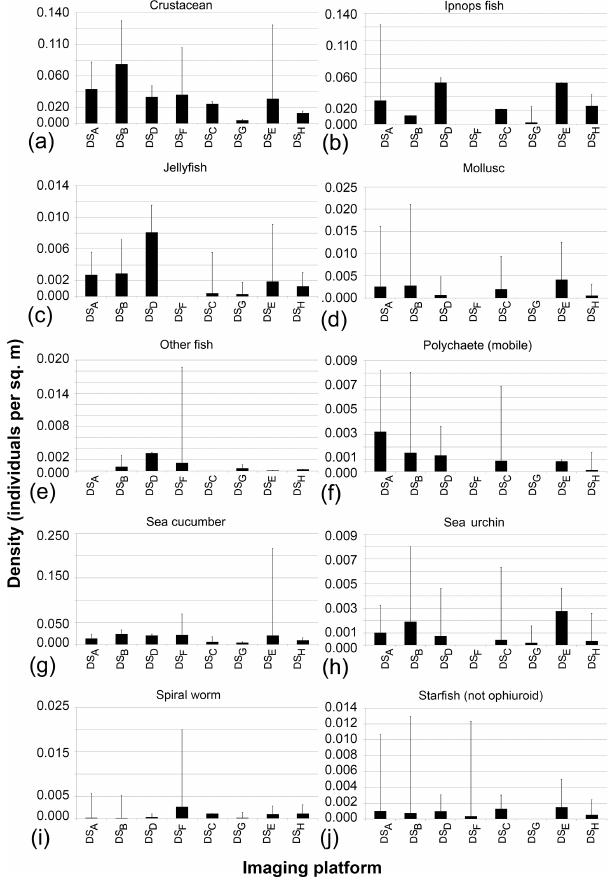
Figure 8. Mobile-fauna abundances averaged across five annotators that independently annotate image data collected during the eight survey